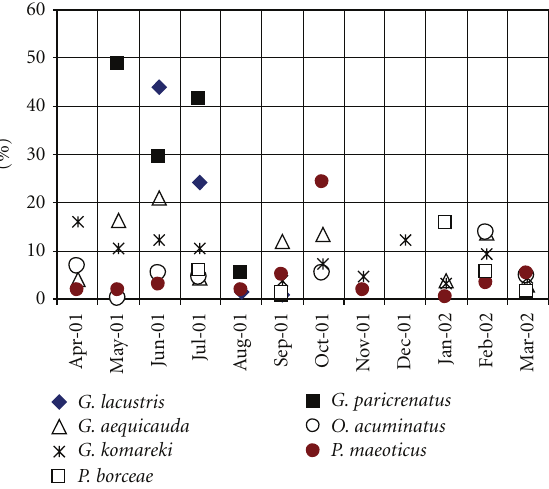
Figure 3: The newly hatched and juvenile ( < 4mmlong) individuals for each species during April 2001 to March